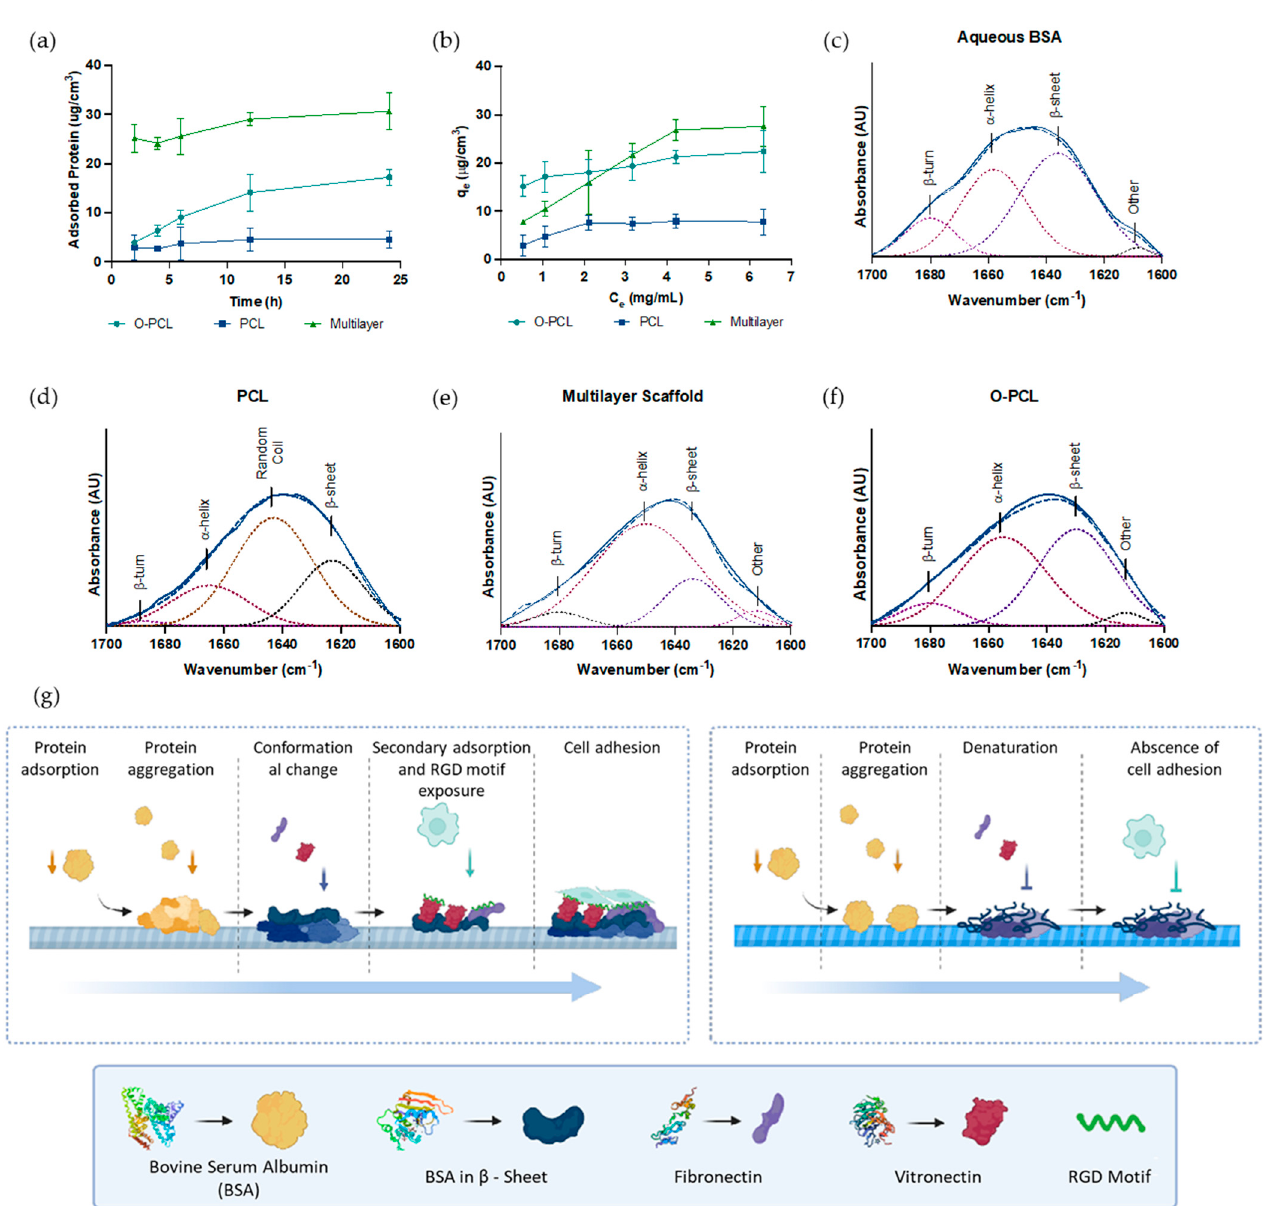
Figure 4. FBS protein adsorption. ( a ) Proteins adsorbed on a per volume basis as quantified via the BCA assay. Almost 12 h were needed to reach a steady state in protein concentration. ( b ) Protein adsorption isotherms. Secondary conformational changes of BSA estimated via FTIR deconvolution of the amide I absorption band (1600—1700 cm − 1 ) of ( c ) aqueous BSA (control of native